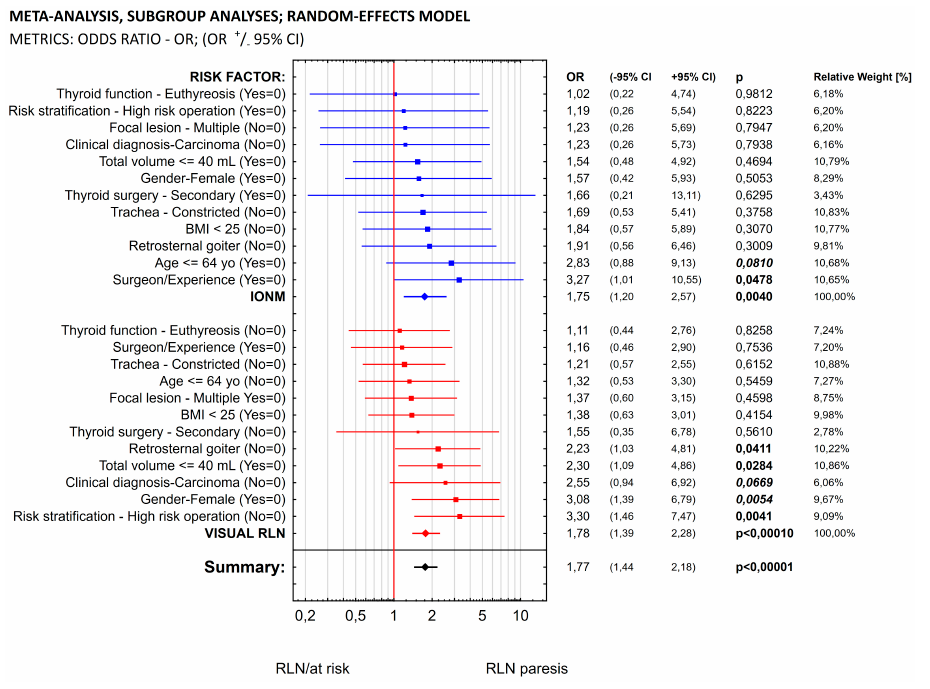
Figure 1. Meta-analysis, subgroup analyses (IONM vs. VA) and random effects model.